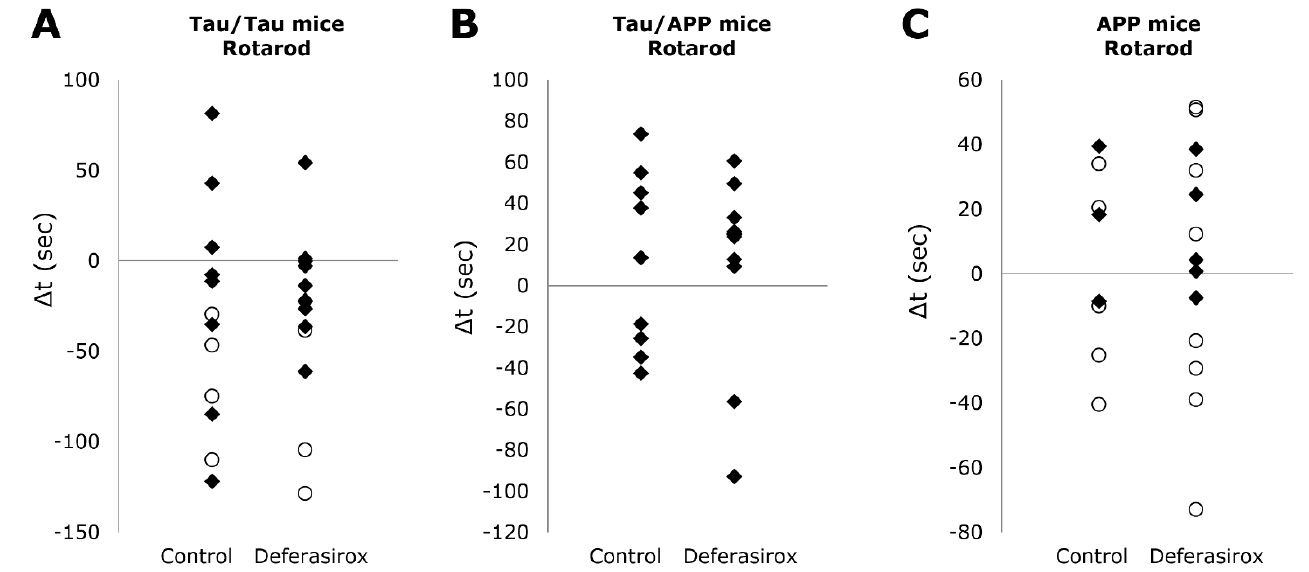
Figure 3. Deferasirox did not significantly affect differences in the time mice stayed on the rotarod (seconds, vertical axis) between the start and end of treatment for ( A ) Tau/Tau ( p = 0.94), ( B ) Tau/APP ( p = 0.96), or ( C ) APP ( p = 1.00) mice. Males are black diamonds, and females are white circles. By age 14 months, female Tau/APP mice had deteriorated to such a degree that they were not fit for rotarod tests, thus only males were studied.